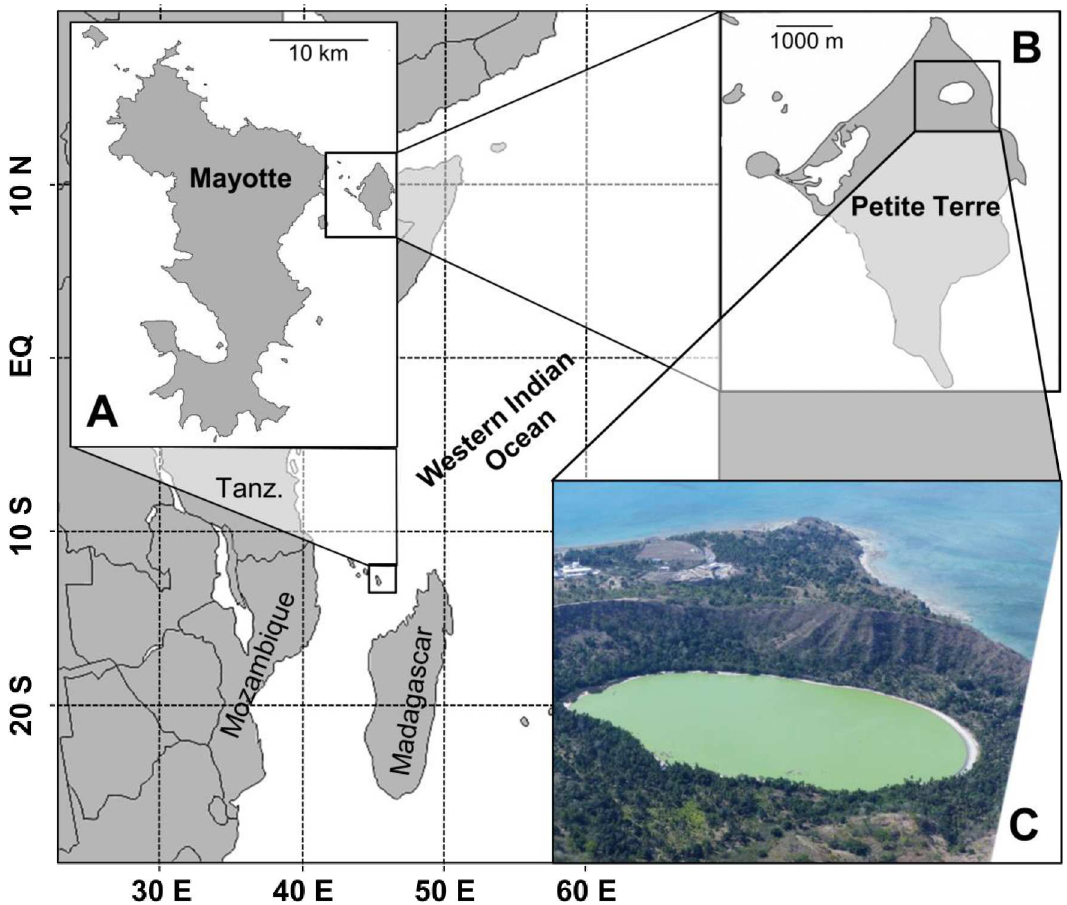
Fig 1. Situation map of study site. (A) Mayotte Archipelago in the Western Indian Ocean, and (B) location of Dziani Dzaha in Petite Terre. (C) An aerial view from an ultra light plane is given, facing North. Picture took in October, 2014, in dry season at low water level. West to East distancebetweenshorelinesis 650